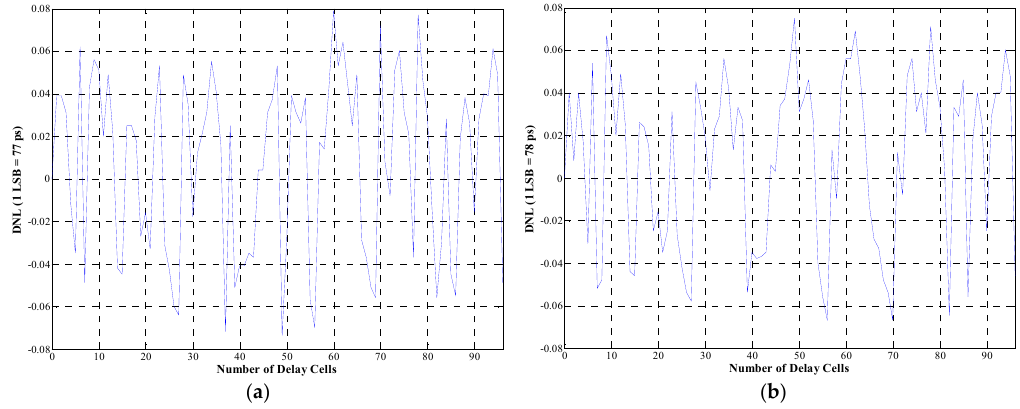
Figure 10. Differential nonlinearity (DNL) of delay cells in a PDL. ( a ) DNL of delay cells in PDLA237~PDLA239; ( b ) DNL of delay cells in PDLB237~PDLB239.